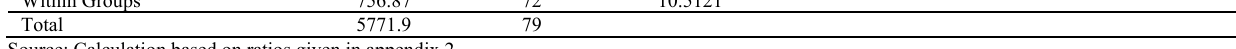
ANOVA of PBIT ratio of Indian leading automobile companies Source of Variation SS df MS Source: Calculation based on ratios given in appendix 2.